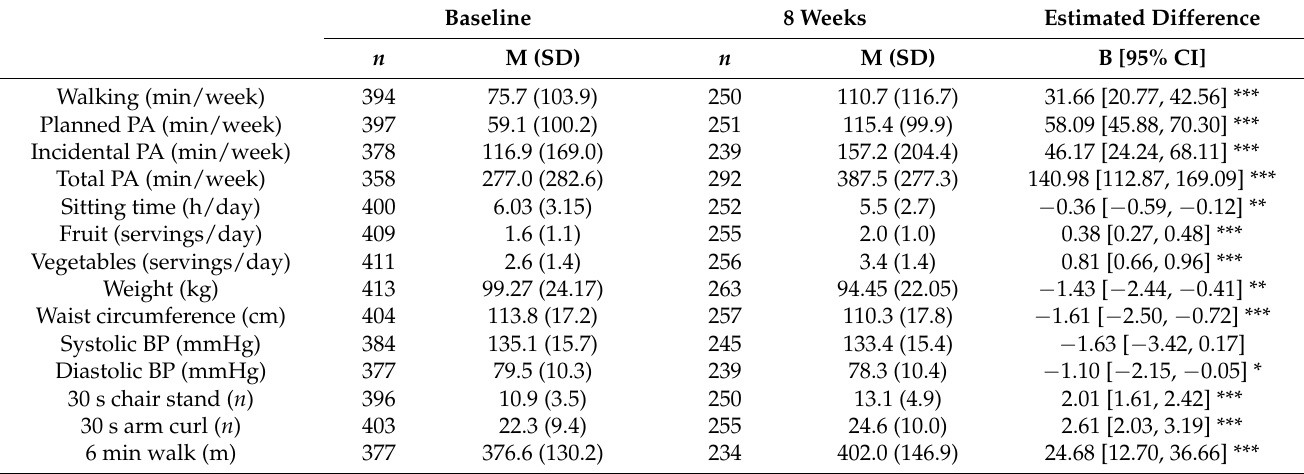
Table 2. Descriptive statistics and results from multilevel models examining the effectiveness of the HEAL TM program.